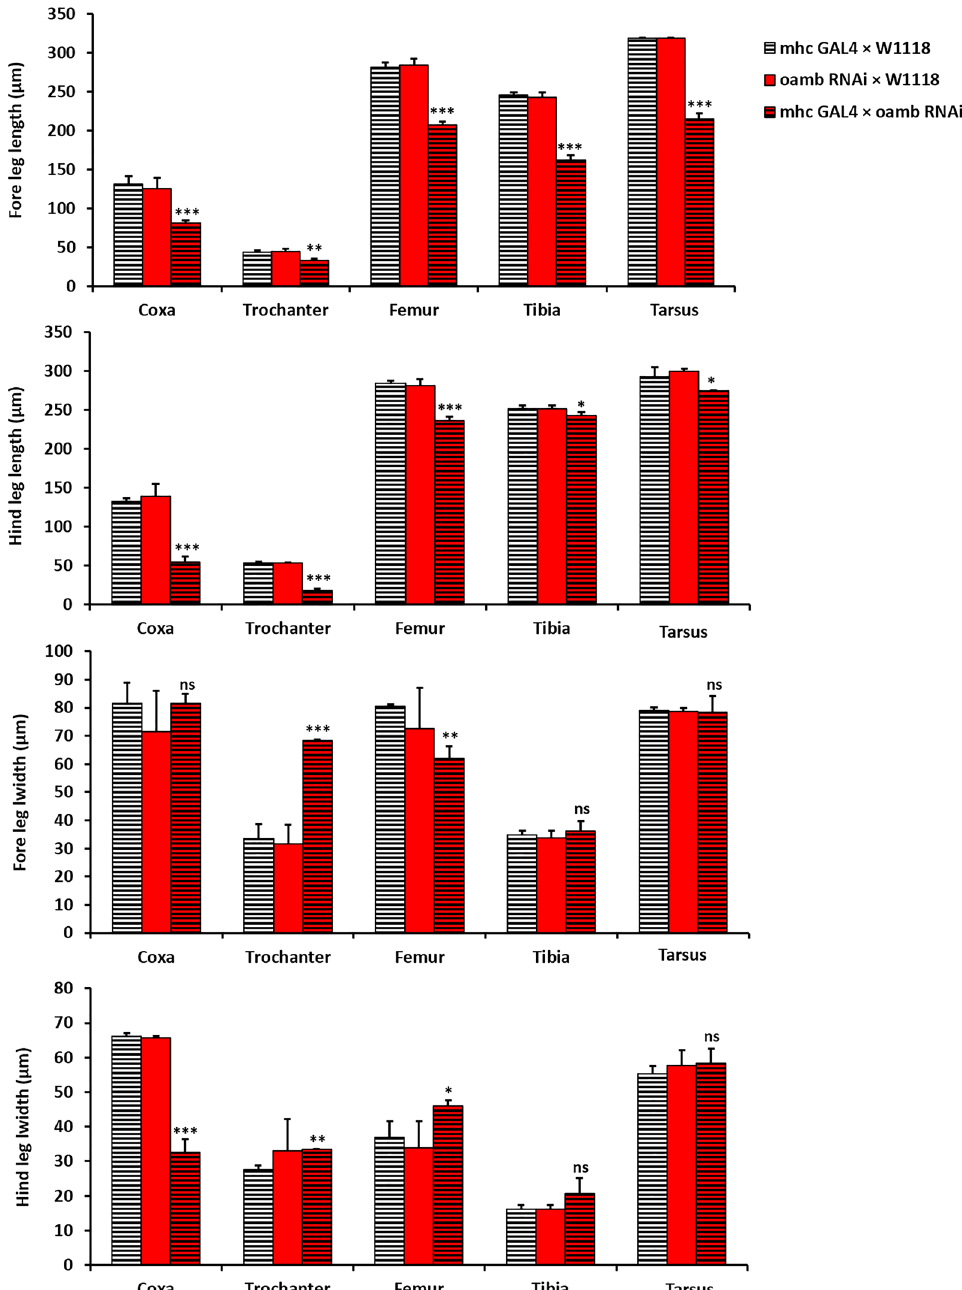
Figure 6. Length and Width of fore and hind legs’ parts of adult flies that lost the expression of octαR in muscular system as well as matching control adult Drosophila males. Mean ± SD; N = 10; * P ˂ 0.05, ** P ˂ 0.01, *** P ˂